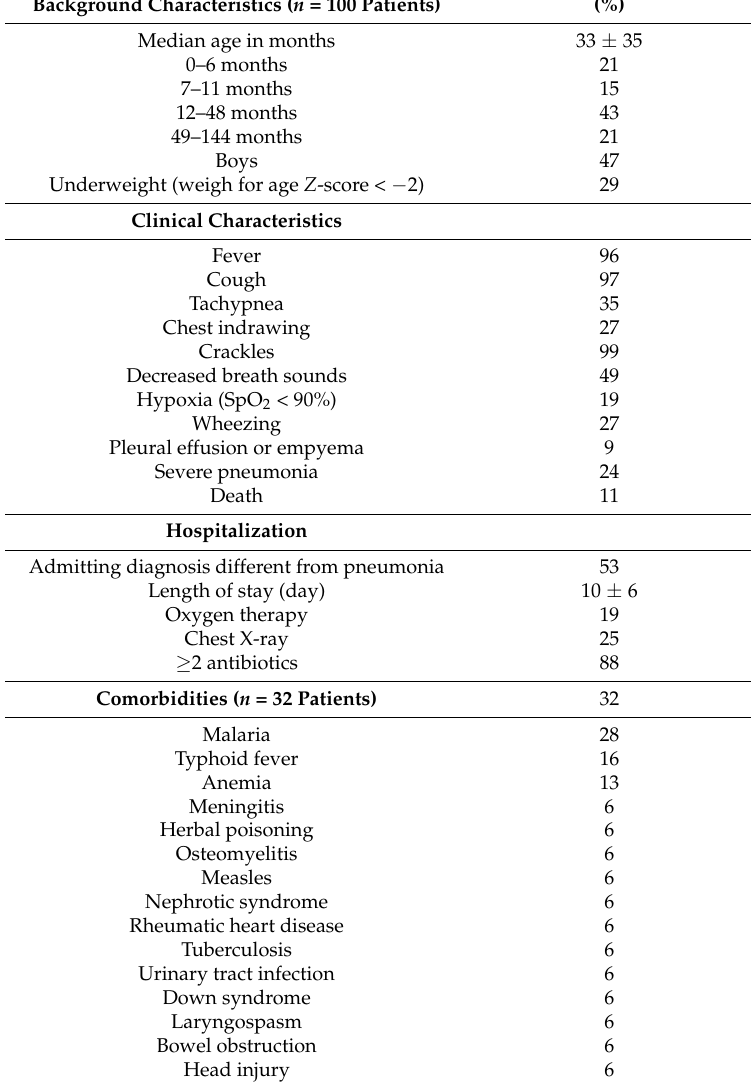
Table 1. Demographics and clinical characteristics of the study